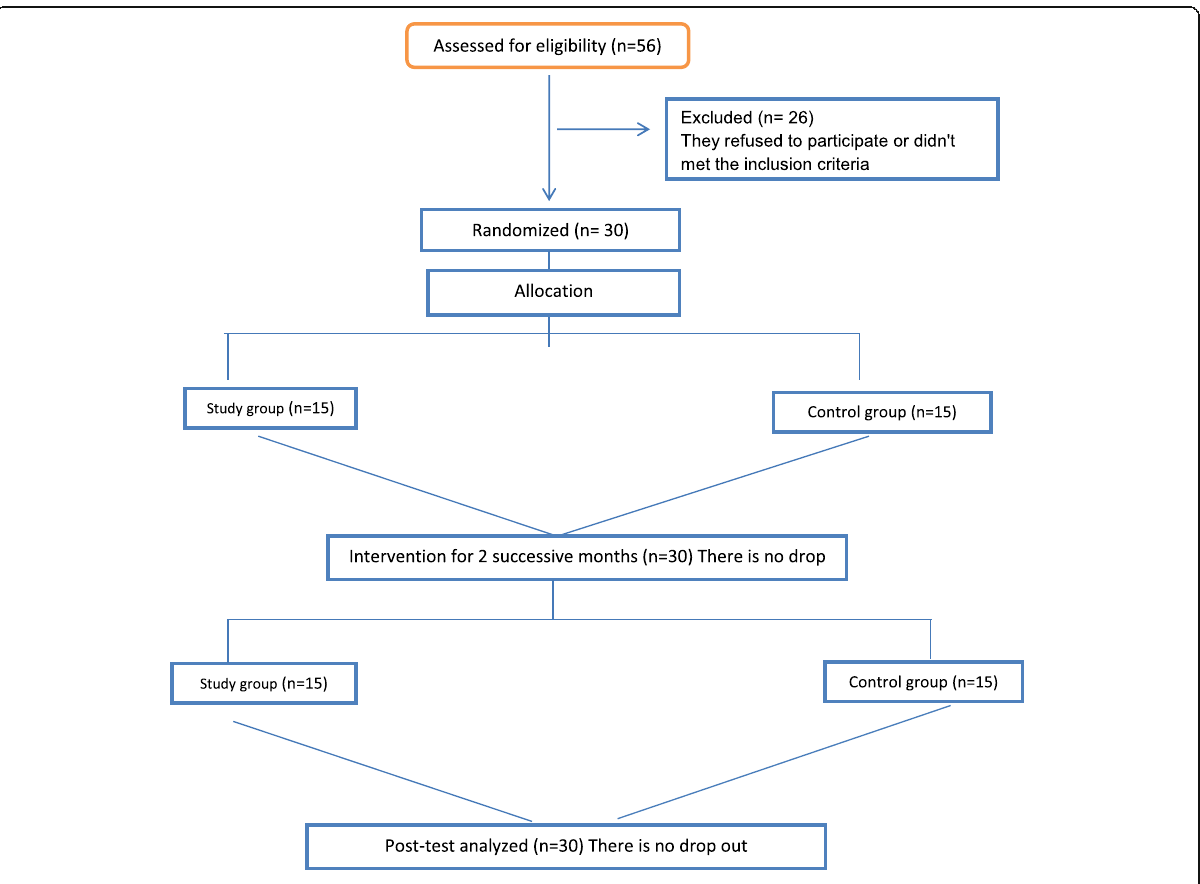
Fig. 1 CONSORT flow chart of the children